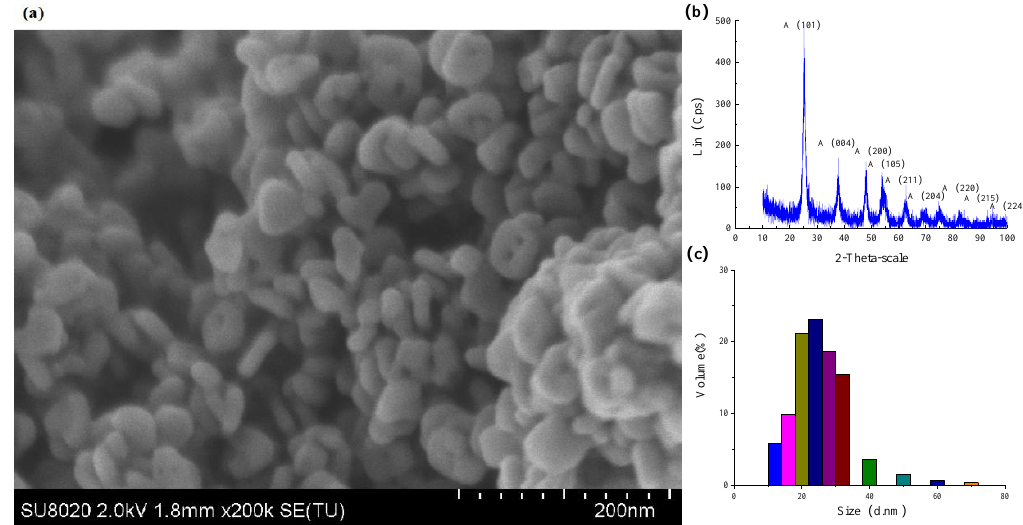
Figure 18. TiO 2 nanoparticles used in the experiments. ( a ) SEM, ( b ) XRD pattern and ( c ) Diameter distribution.